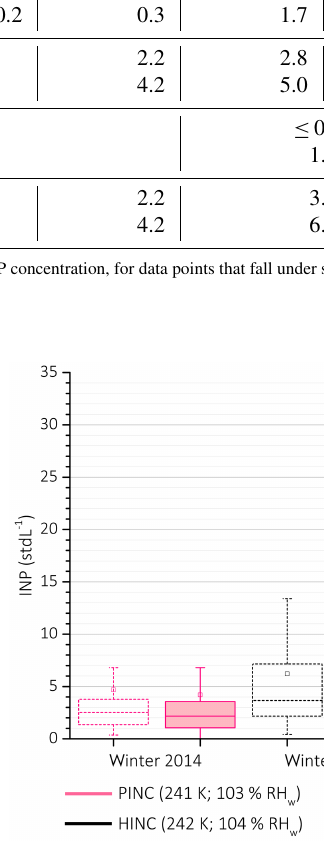
Figure 9. Averaged INP concentrations observed above water sat- uration (see legend for exact temperature and RH conditions). Dashed box plots represent only INPs > LOD, while solid box plots include INPs < LOD (see Sect. 2.3 for details). Median: middle bar; mean: open square data point; box: interquartile range (25th to 75th percentiles); whiskers: 5th and 95th percentiles. Data used to produce the distributions exclude contributions from measure- ments during periods of known air masses arrived at the JFJ (see Sect. 4.2) with anomalously high INP concentrations. See Table 1 for field campaign sampling